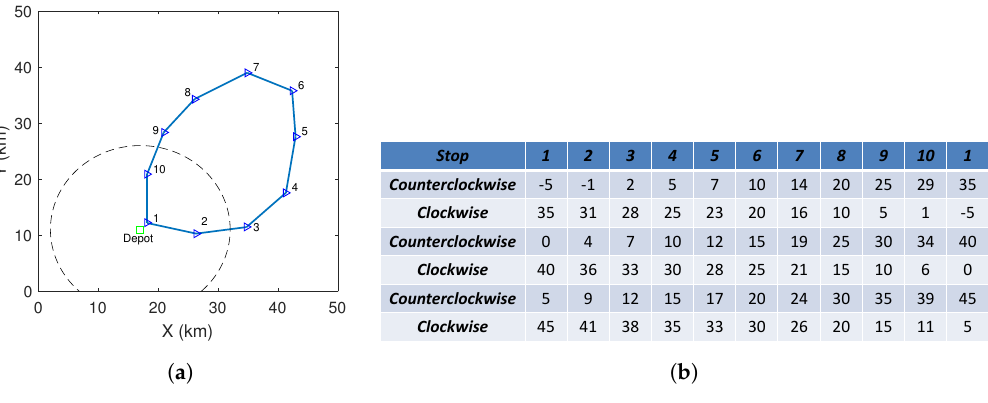
Figure 5. ( a ) The considered area with a circular trajectory. ( b ) Timetable T (in minutes).